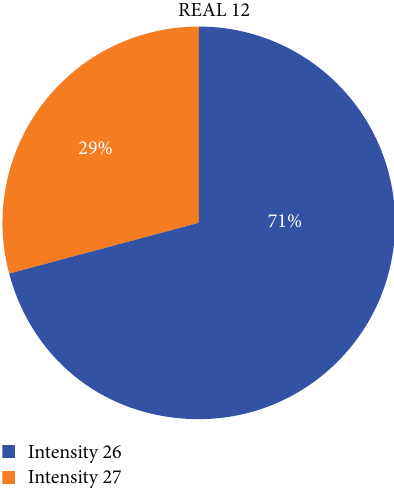
F IGURE 17: REAL 12 result distribution without local search mechanism.